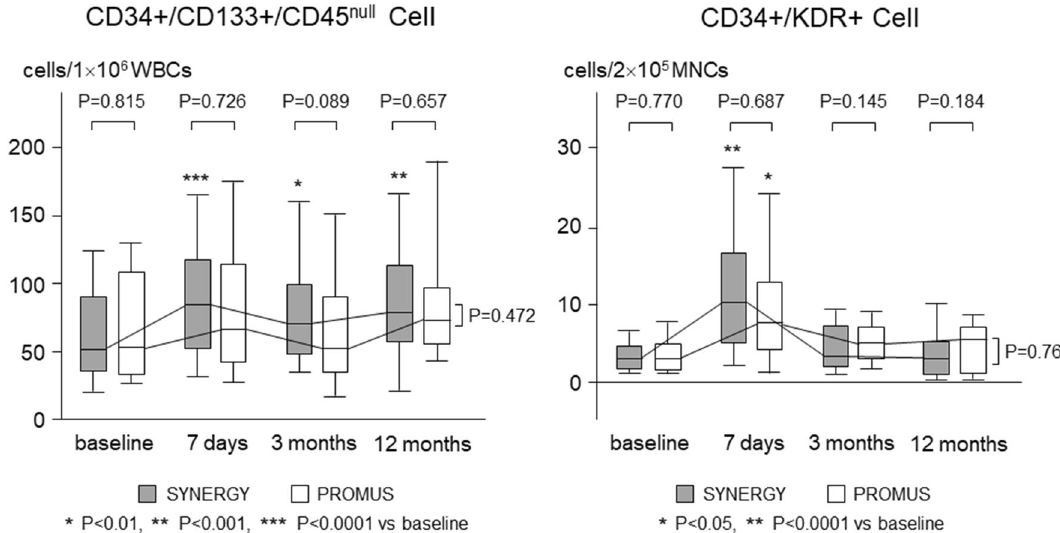
Figure 2. Comparison of serial changes in circulating progenitor cells during acute phase after stent implantation between 2 groups of SYNERGY and